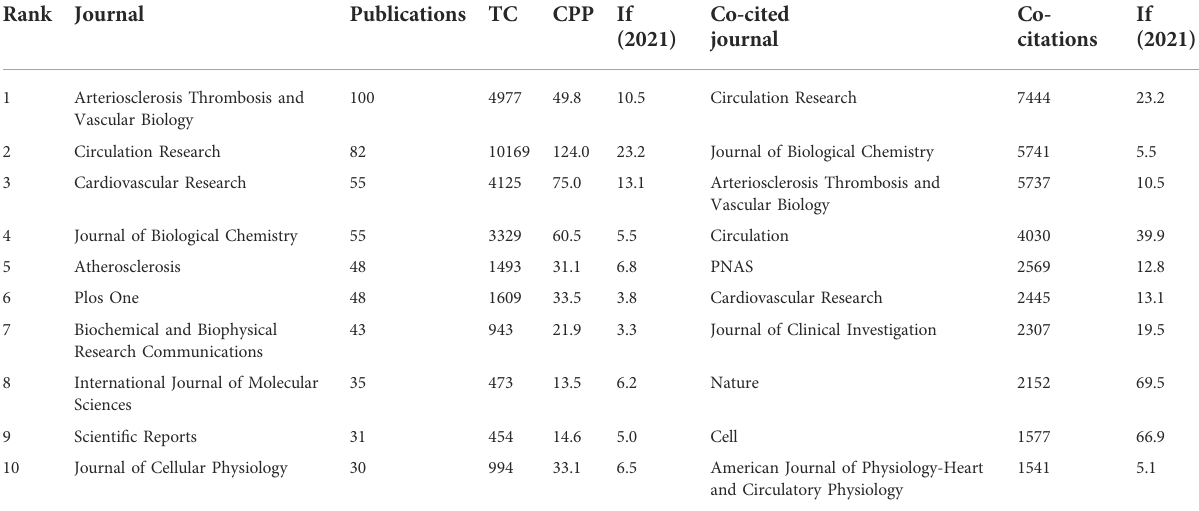
TABLE 1 Top 10 proli fi c journals and co-cited